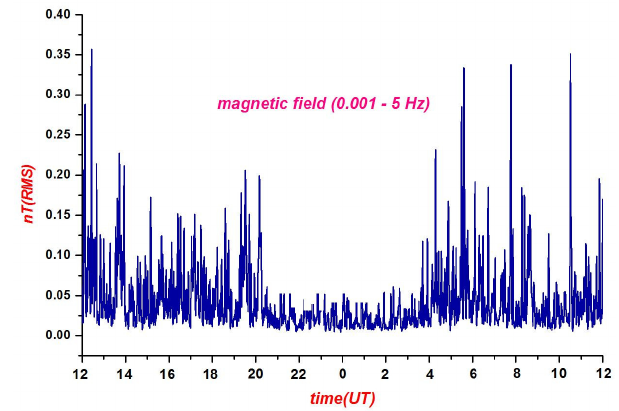
Fig. 2 Diurnal variation of background noise (time window) Fig. 2. Time window, diurnal variation of background